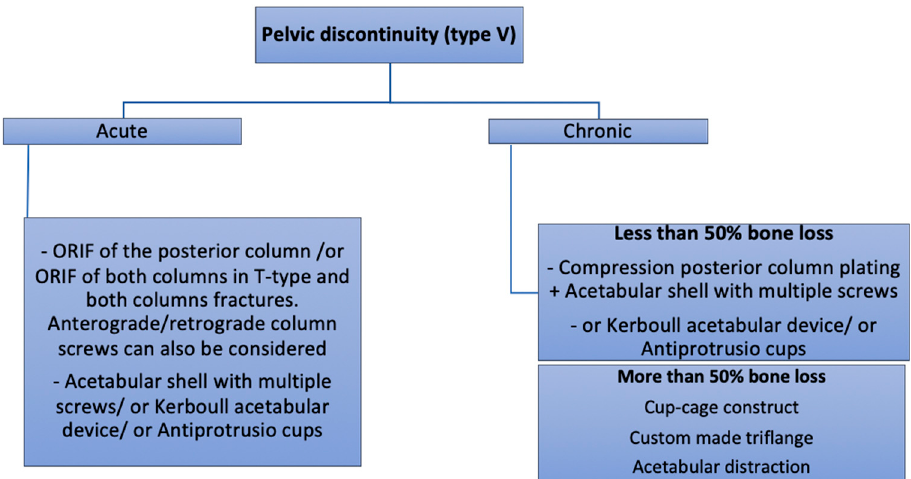
Figure 8. Authors preferred treatment algorithm for pelvic discontinuity.